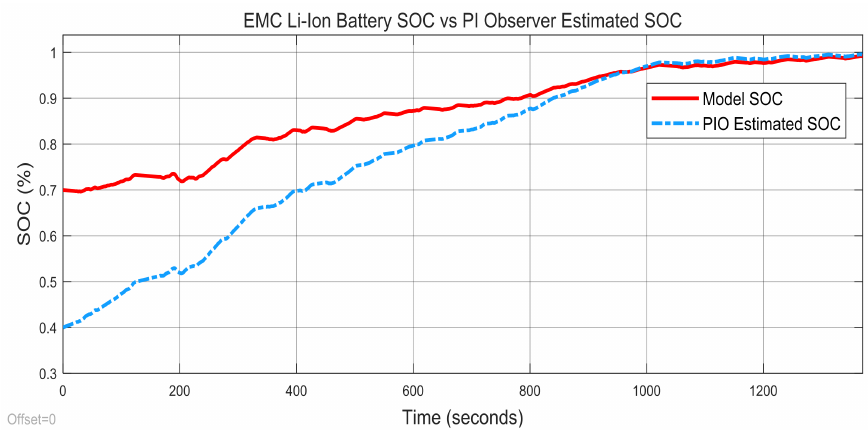
Figure 35. The robustness of 2RC EMC Li-Ion battery PIO SOC estimator to the changes in SOC initial value from 70 to 40%.